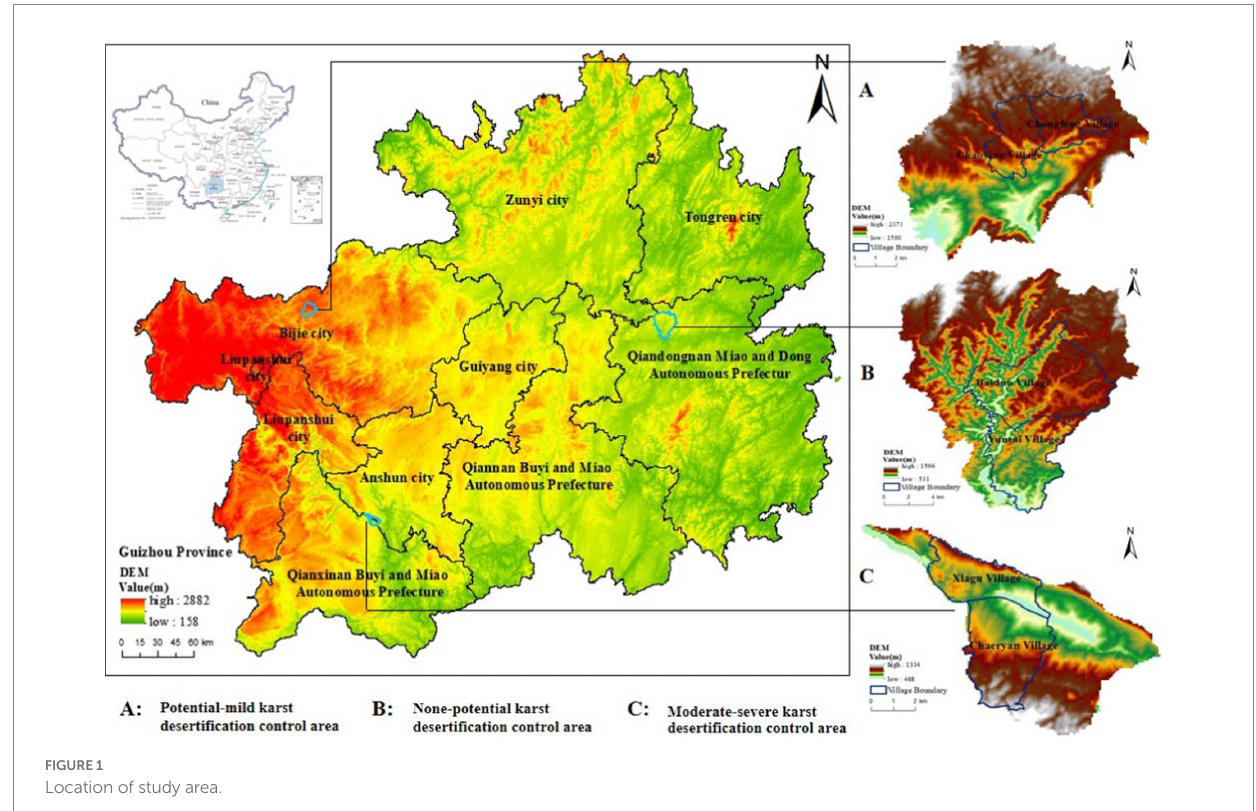
FIGURE 1 Location of study